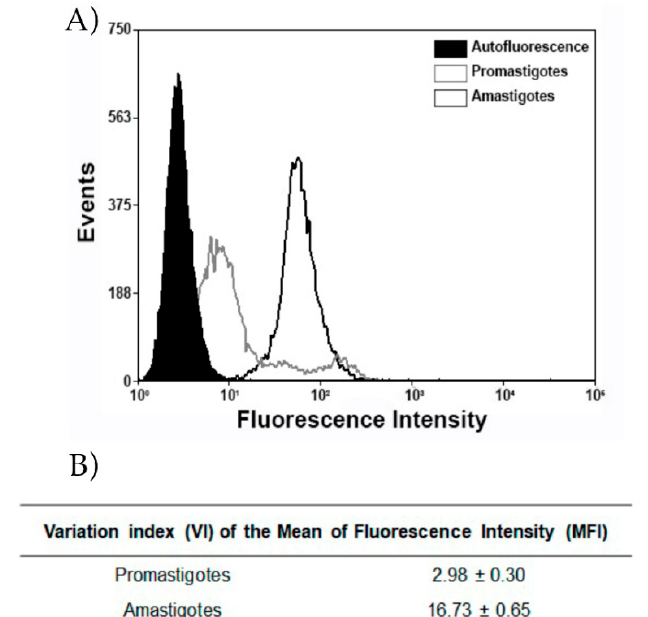
Figure 6. Intracellular protein expression of subtilisin in promastigotes and axenic amastigotes. ( A ) Flow cytometry analysis of L. amazonensis axenic promastigotes and amastigotes (RAT/BA/74/LV78). Cells were labeled with the anti-subtilisin antibody (1:400) and an Alexa 488 secondary antibody (green) (1:750). ( B ) The variation index of the mean fluorescent intensity (MFI) was obtained by the division of the MFI from labeled parasites by the non-stained autofluorescence control (black fill).